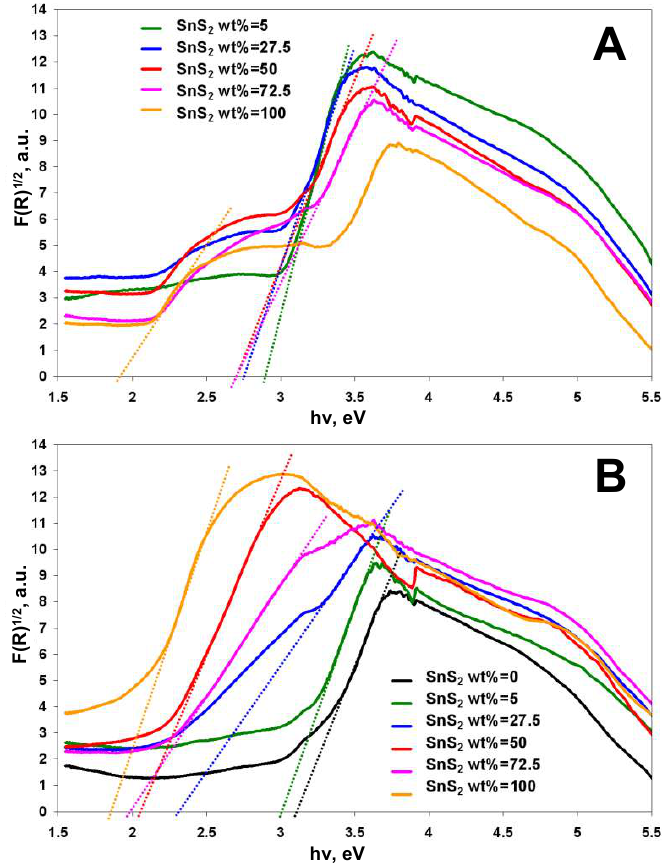
Figure 1. Plot of transformed Kubelka–Munk function vs. the light energy for immobilized TiO 2 -SnS 2 composites with different SnS 2 wt %: commercial (COMM) ( A ) and hydrothermal (HT) ( B